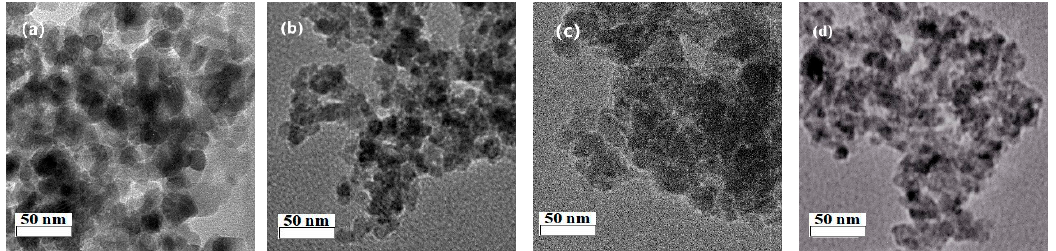
Figure 2. TEM images of ( a ) CuO, ( b ) Cu 0.84 Si 0.16 , ( c ) Cu 0.84 Mg 0.16 , and ( d ) Cu 0.84 Al 0.16 .